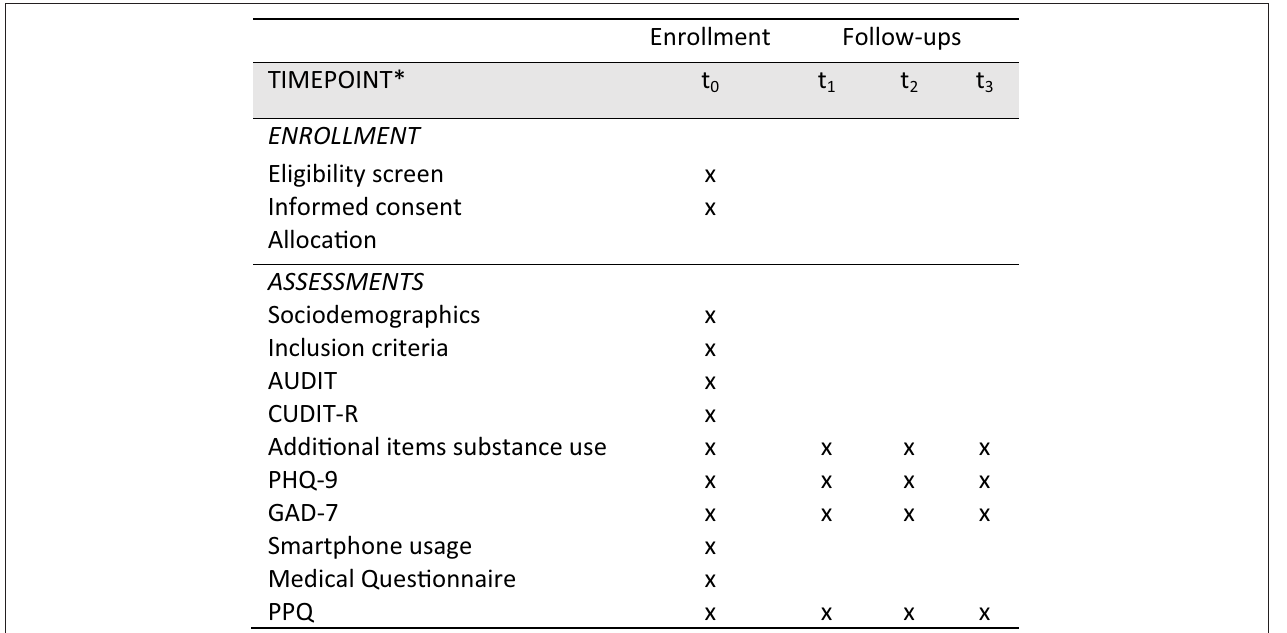
FIGURE 8 | Schedule of enrollment, interventions and assessment. Completed SPIRIT 2013 figure of recommended content of enrollment, interventions, and assessments. t 0 , baseline; t 1 , 4 weeks after baseline (post intervention); t 2 , 16 weeks after baseline; t 3 , 24 weeks after